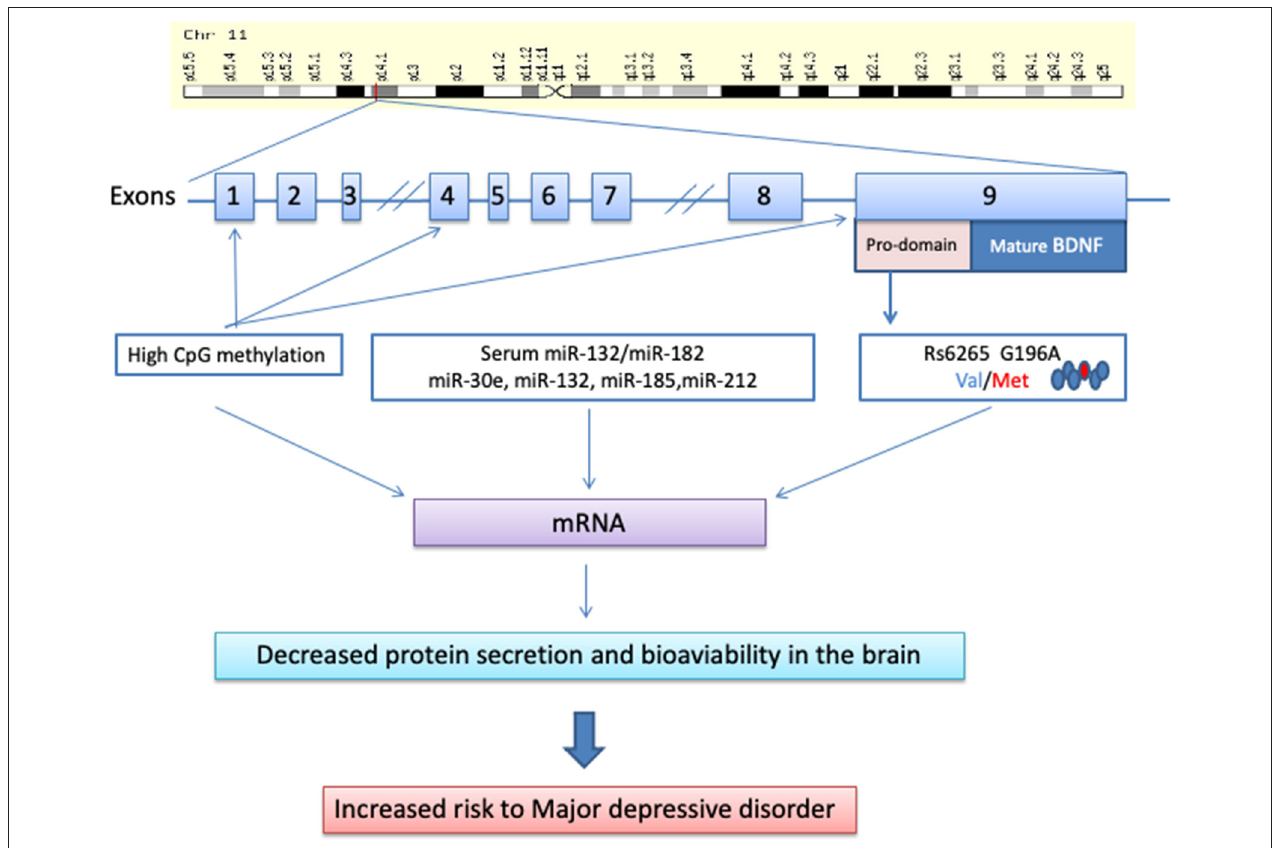
FIGURE 1 | Molecular biology of the brain-derived neurotrophic factor and its way toward major depressive disorder.